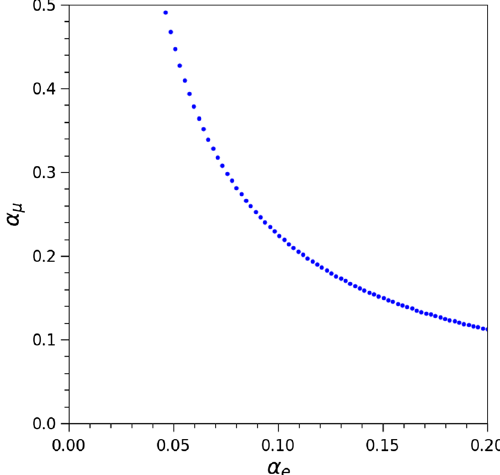
Fig. 1 Allowed values for α e and α μ for the best fit value of sin 2 θ LSND , as discussed in the text